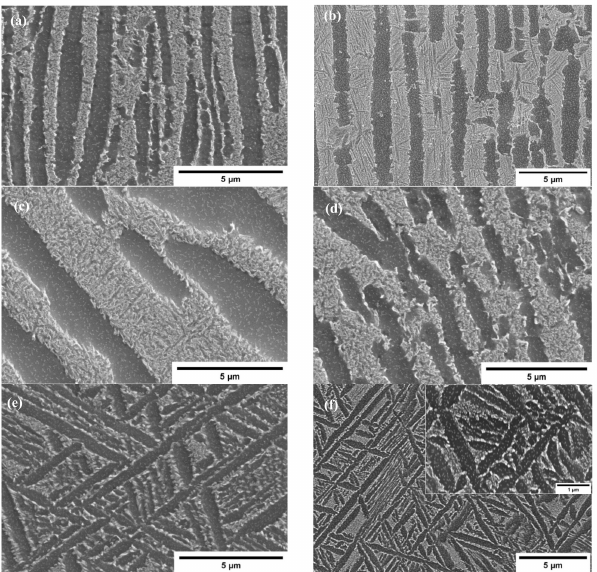
Figure 10. Typical SEM microstructure images of Ti6Al4V-5Cu alloy observed at high magnification during hot deformations at different temperatures and strain rates of ( a ) 840 ◦ C and 1 s − 1 , ( b ) 840 and 10 − 1 s − 1 , ( c ) 790 ◦ C and 10 s − 1 , ( d ) 840 ◦ C and 10 s − 1 , ( e ) 890 ◦ C and 1 s − 1 , and ( f ) 940 ◦ C and 10 − 2 s − 1 .